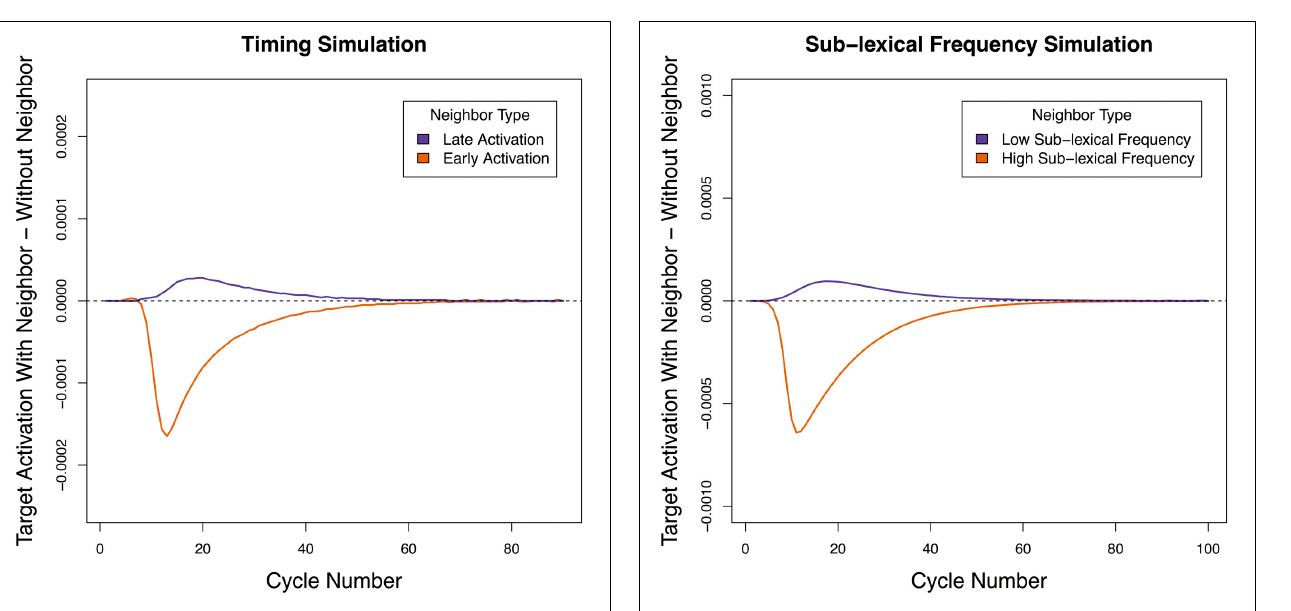
FIGURE 3 | Net contribution of a handshape neighbor and a location neighbor when the timing of sub-lexical sub-lexical unit activation was manipulated. Handshape neighbors had a net facilitatory effect on the target, while location neighbors had a net inhibitory effect on the target.